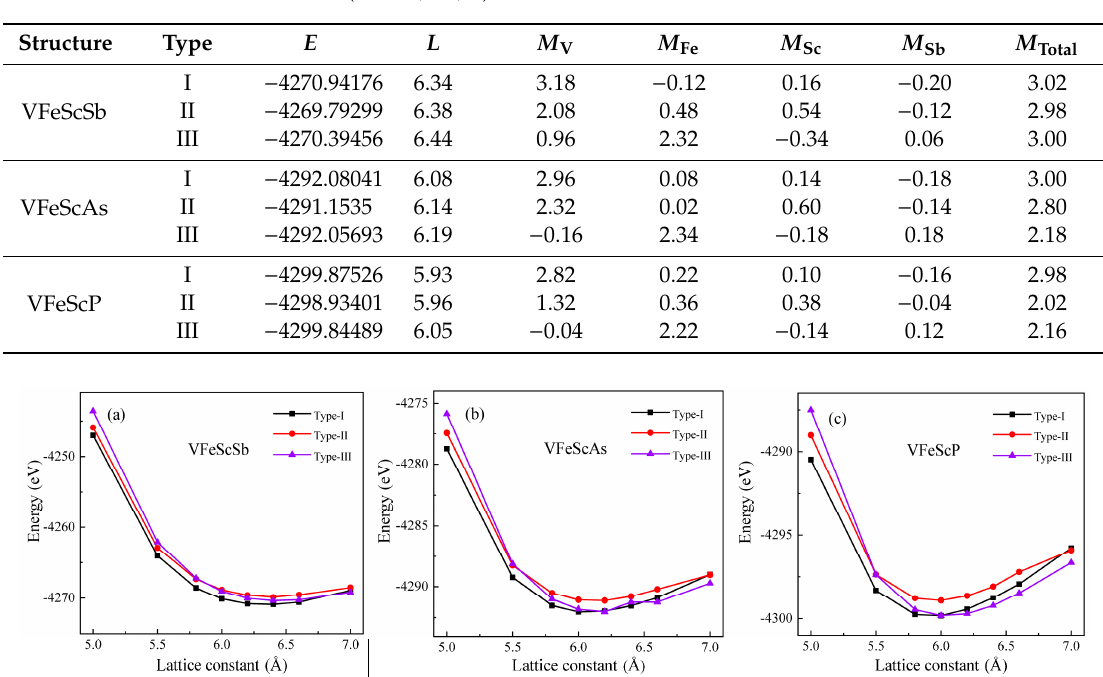
Figure 3. Total energy as a function of lattice constant in the Heusler alloy ( a ) VFeScSb, ( b ) VFeScAs, and ( c ) VFeScP with type-I, -II, and -III structures.